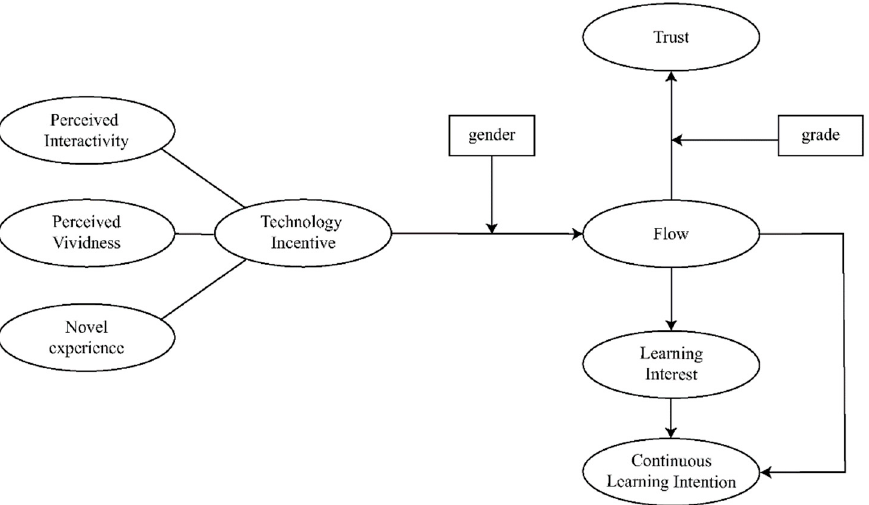
Figure 5. Technology incentive model